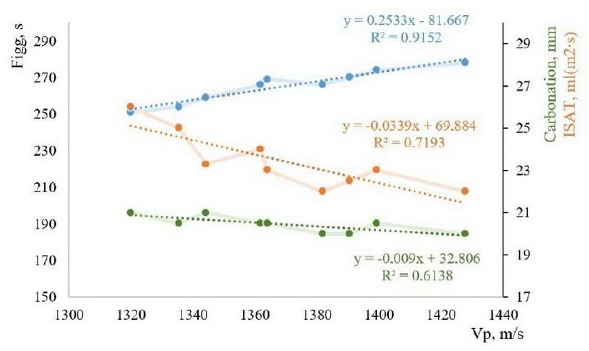
Figure 3: Plots of the dependence of the Figg index and carbonation degree on wave propagation velocity for concrete after fire simula- tion. ( Source: authors’ elaboration